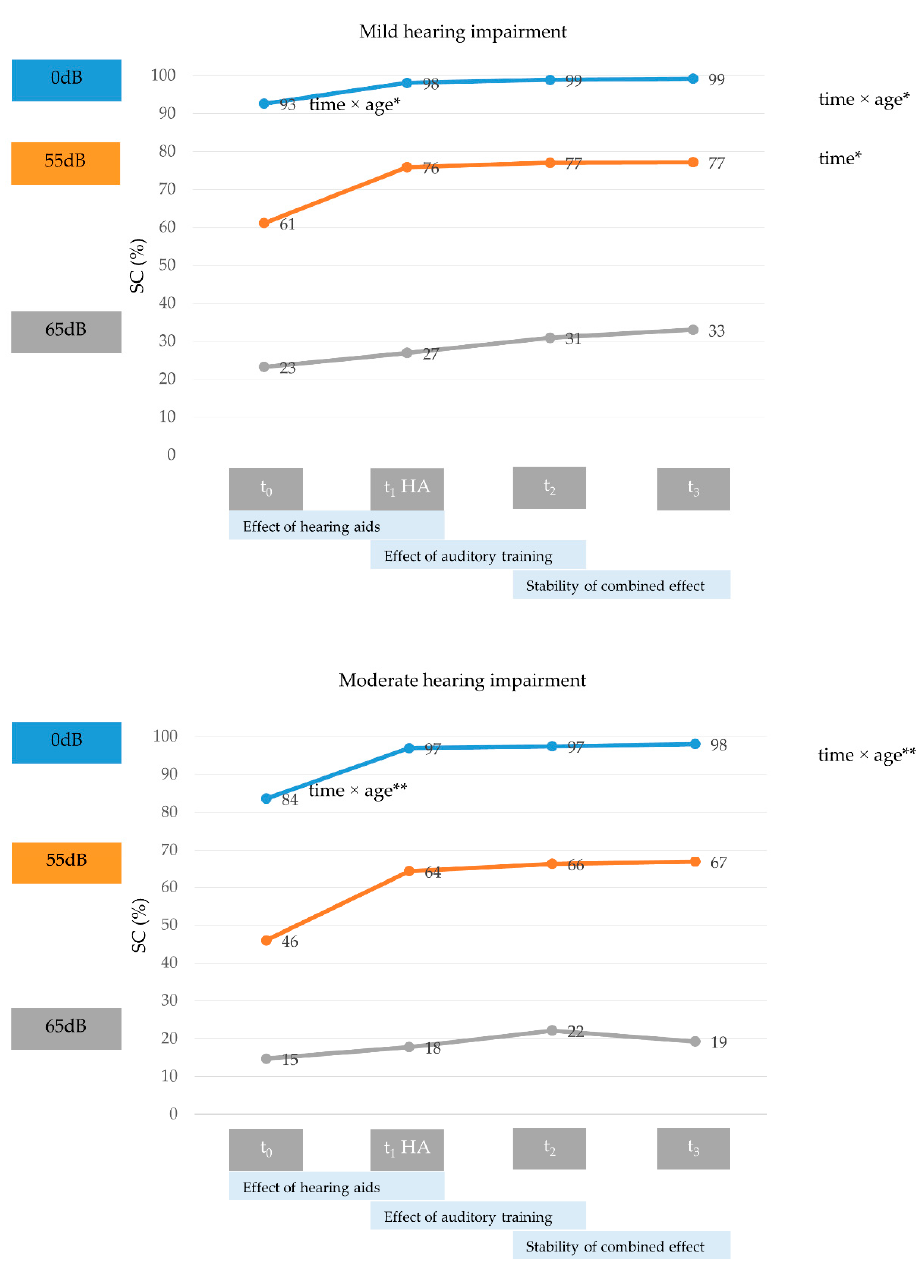
Figure 2. Effects of Terzo © hearing therapy on speech comprehension. At 0 dB noise interference, the intervention yielded significant time × age interaction effects for patients with mild and moderate hearing loss. At 55 dB noise interference, the intervention yielded a significant main effect of time for patients with mild but not moderate hearing loss. HA = hearing aid fitting, SC = speech comprehension, * = p < 0.05; ** = p < 0.01.